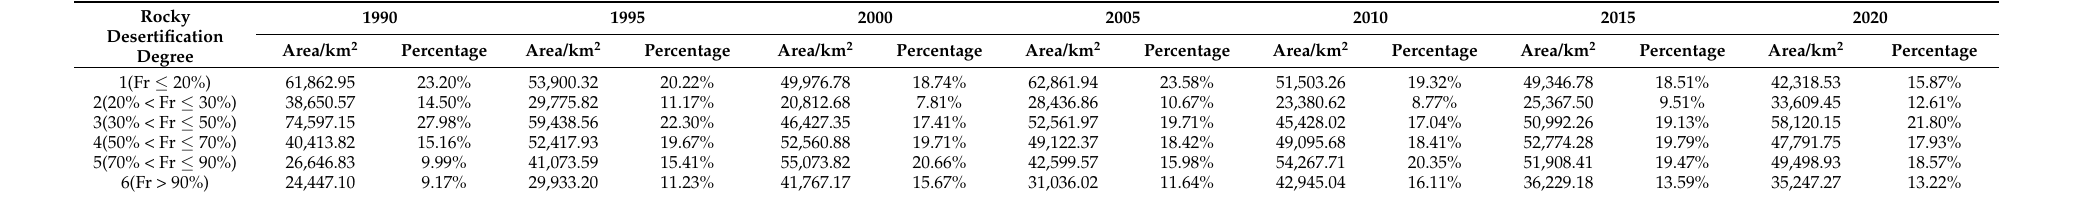
Table 3. Hierarchical statistics of rocky desertification degree in Yunnan karst rocky desertification areas